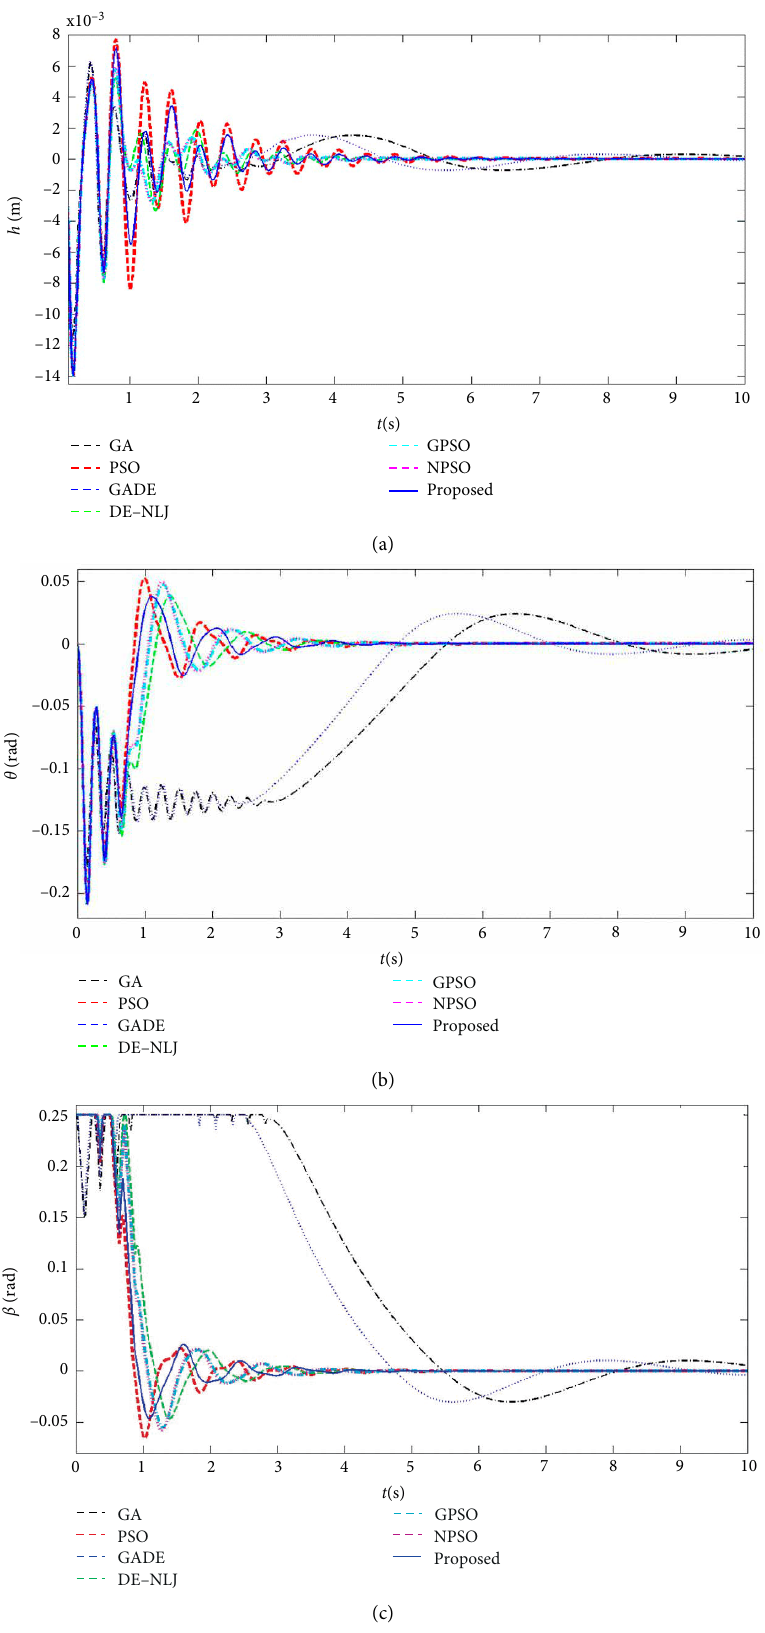
Figure 8: Comparison of (a) plunging response, (b) pitch response, and (c) control effort obtained by GA, PSO, NPSO, GPSO, DE–NLJ, GADE and GNPSO based IMC-PID control of nonlinear wing vibration